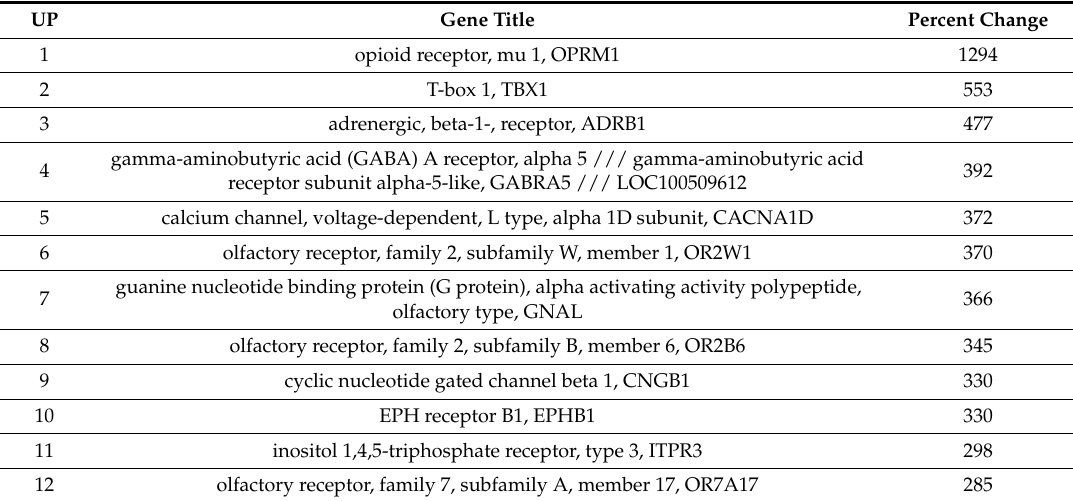
Table 28. GHK and Gene Associate with Sensory Nerve